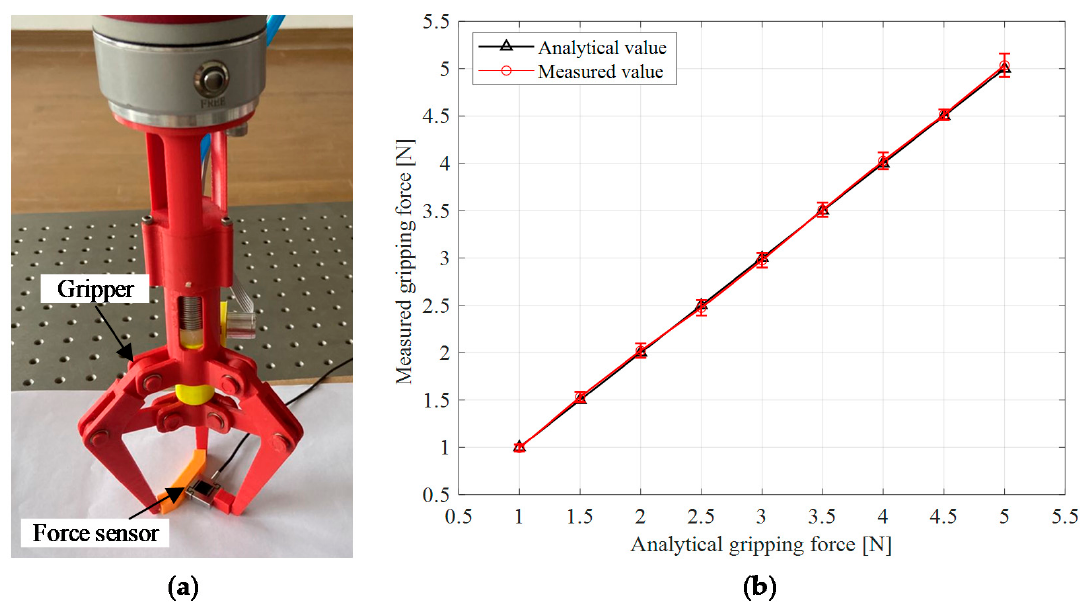
Figure 11. Gripping force measurement for the designed gripper: ( a ) gripping force measurement method illustration; ( b ) gripping force measurement result.